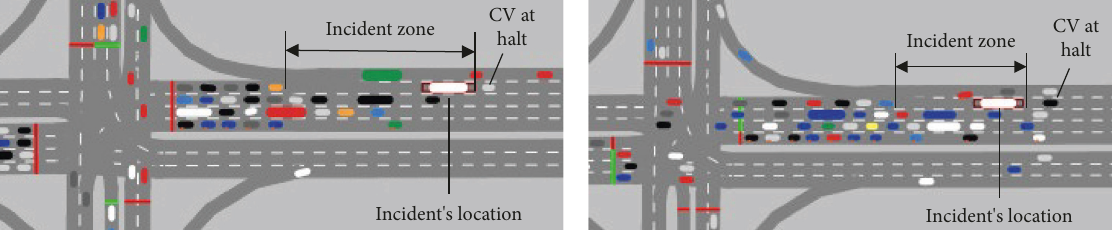
Figure 3: Depiction of the incident